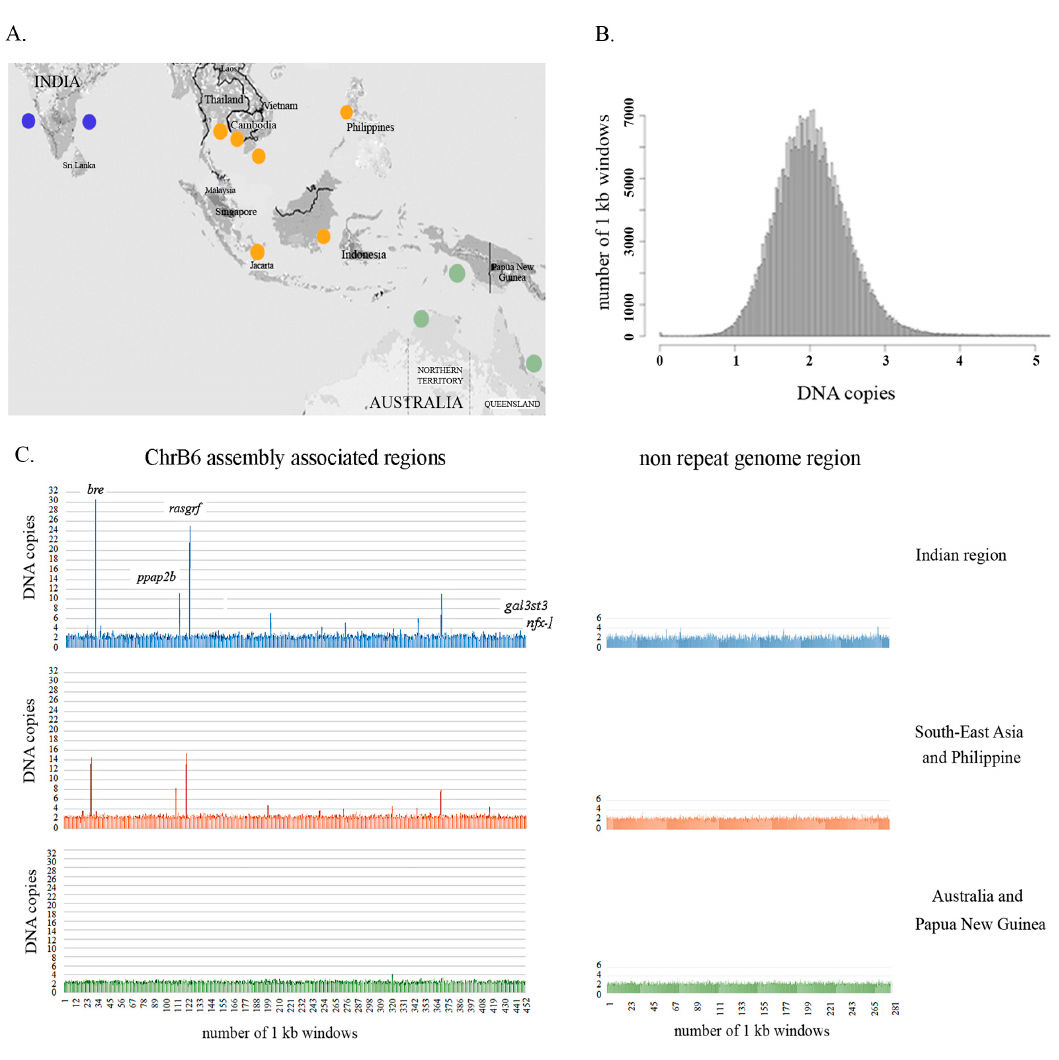
Figure 4. Population-scale variation in the copy number of B chromosome-associated regions in the Asian seabass species complex. ( A ) Geographic regions across the native range of Asian seabass: Western and Eastern Coast of India; South-East Asia and the Philippines, Australia/Papua New Guinea. ( B ) Distribution of inferred genome fragment copy number in 1 kb windows across the Asian seabass genome: Homozygous deletion, 0.1–1.4; heterozygous deletion, 1.5–2.5; normal diploid copy number, 2.6–4; heterozygous duplication, > 4; multiple duplications. X-axis: DNA copies; Y-axis: Number of 1 kb windows. ( C ) Population-scale variations in the copy number of the Bchr6-associated region and control genome fragment were demonstrated for the three geographical regions. X-axis: Number of genomic fragments which correspond to a particular 1 kb window of the reference genome for each individual. Y-axis: Genomic fragment copy number in 1 kb windows across the Bchr6-associated region and non-repeat genomic fragment. The order is indicated in Table S3: Indian region (blue), South-East Asia and Philippine region (orange), Australia/Papua New Guinea region (green). The copy number of control genes ( gal3st3 , znfx-1 ) is presented in 442–452 regions. The estimation of copy number variation was performed after repeat masking, so the number of DNA fragments and size of the analyzed sequences were less than the source. The Asian seabass genome assembly version 2.0 was used as a reference genome.